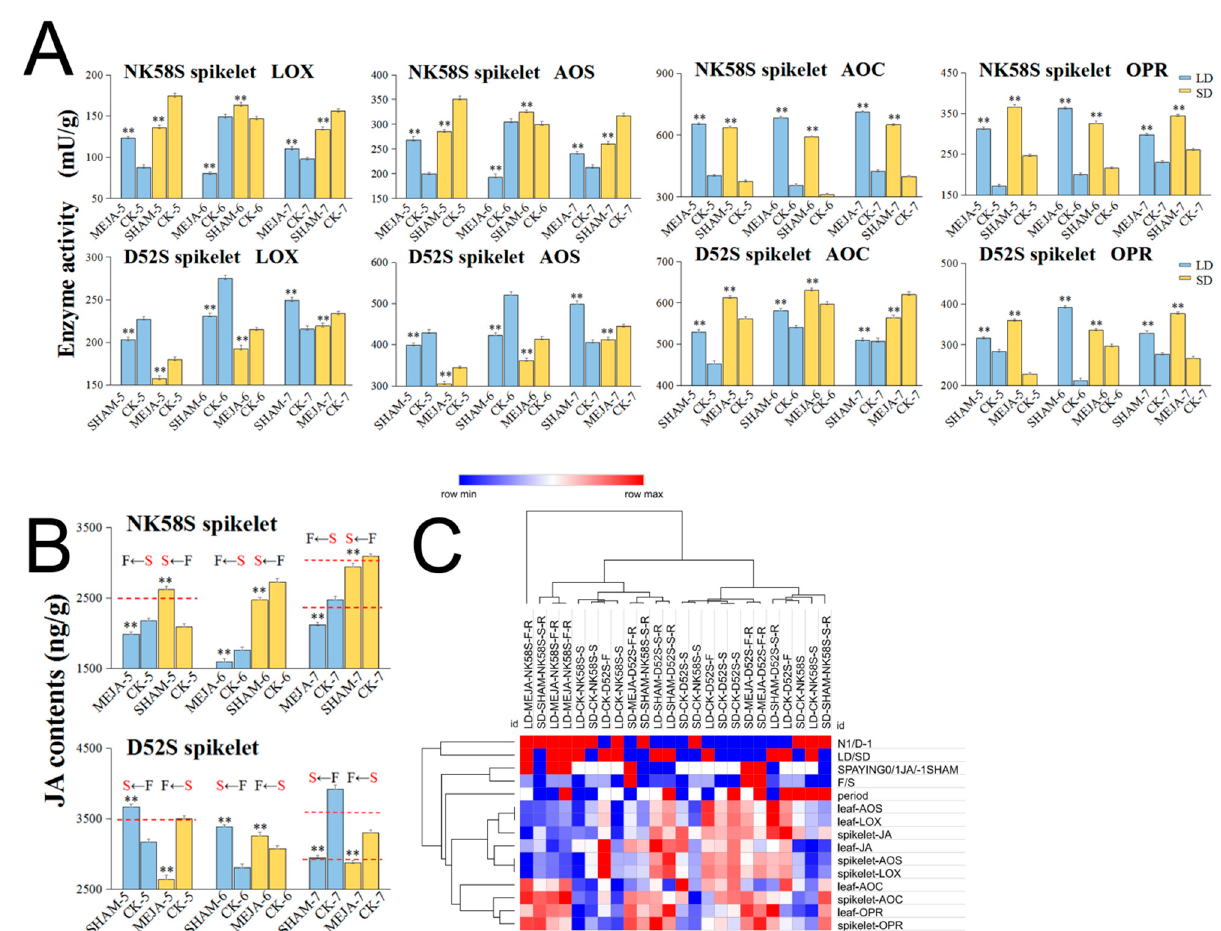
Figure 5. Analysis of JA synthesis enzyme activities and contents in D52S and NK58S by MEJA/SHAM-spraying treatment. The enzyme activities of LOX, AOS, AOC and OPR in the spikelets from NK58S and D52S ( A ), the JA contents ( B ), and heatmap analysis ( C ) are also listed. The LD/SD treated plants are columnar with blue/yellow color, respectively, and the spraying plants were named CK/MEJA/SHAM in the X-axis. The reversed-fertility plants are marked with arrows. The data homogenization for heatmap analysis are treated with maximum and minimum values of each indicator marked in red to blue. Data are shown as mean ± standard deviation ( n = 3). Asterisks indicate significant differences of enzyme activities between spraying-induced reversed-fertility plants and those in the control group revealed by Student’s t -test (**, p < 0.01). LD, long-day cycle; SD, short-day cycle; MEJA, methyl jasmonate; SHAM, salicylhydroxamic acid; CK, control;